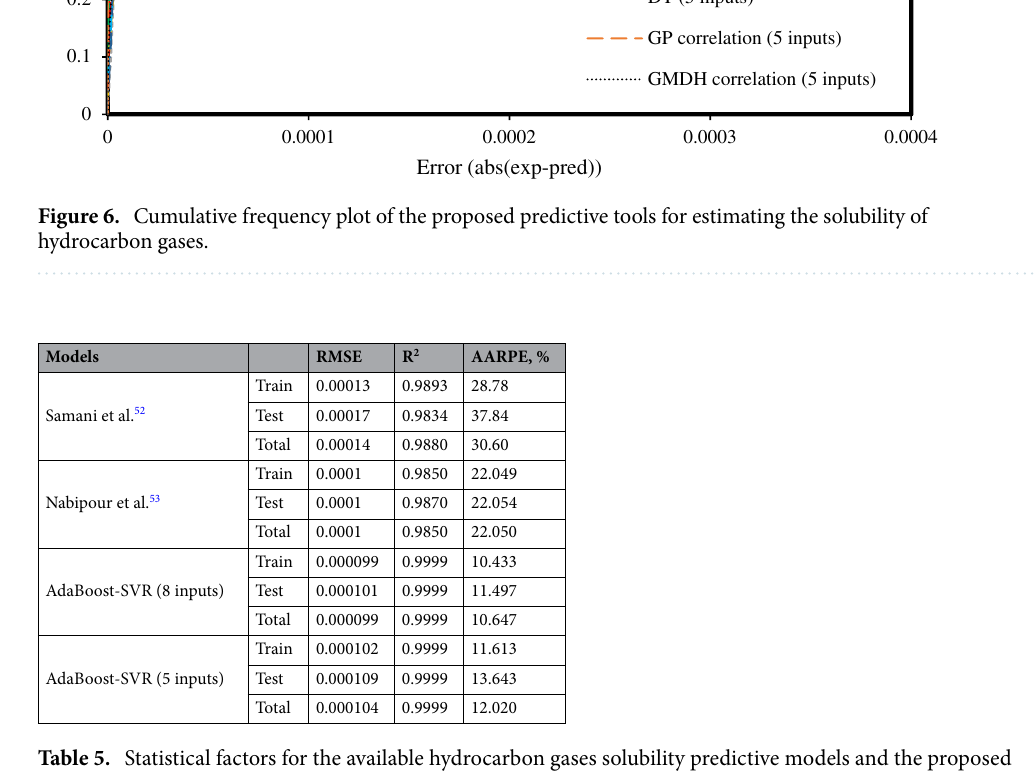
Table 5. Statistical factors for the available hydrocarbon gases solubility predictive models and the proposed AdaBoost-SVR